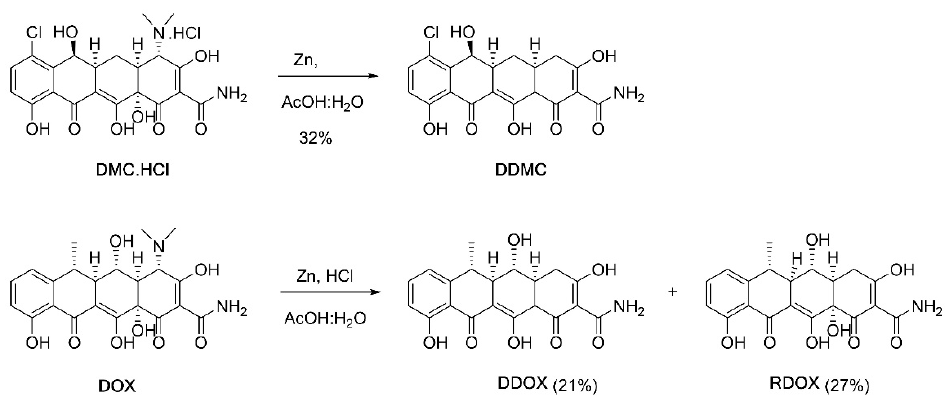
Figure 2. Synthetic route to DDMC , DDOX , and RDOX